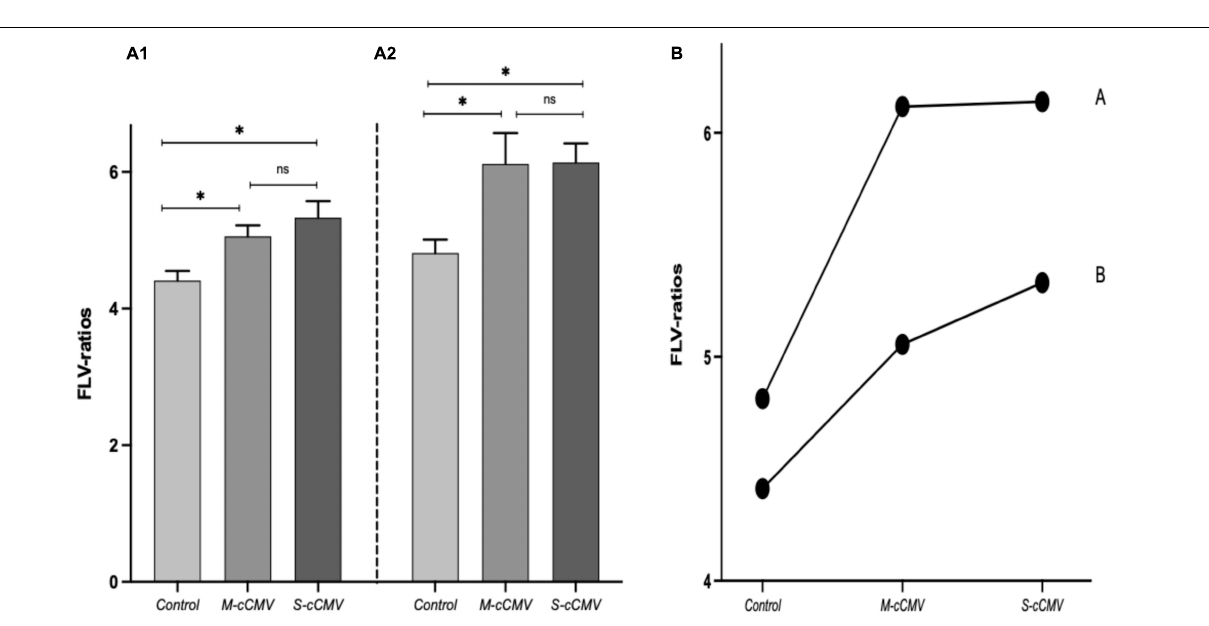
FIGURE 4 | Comparison between the study sub-groups. Fetal liver volume (FLV) ratios. (A1) FLV/AC-ratio, (A2) FLV/FBV-ratio. Data presented as mean (SD). ∗ p -value as determined with analysis of variance and covariance (one-way ANOVA); p < 0.001 . (B) Linear trend analysis: FLV/FBV-ratio (A) , FLV/AC-ratio (B) . Data presented as mean (SD). ∗ p -value as determined with parametric linear regression tendency test; p < 0.001 . Control, healthy fetuses; M-cCMV, mild congenital cytomegalovirus fetuses; S-cCMV, severe congenital cytomegalovirus fetuses; ns, not statistically